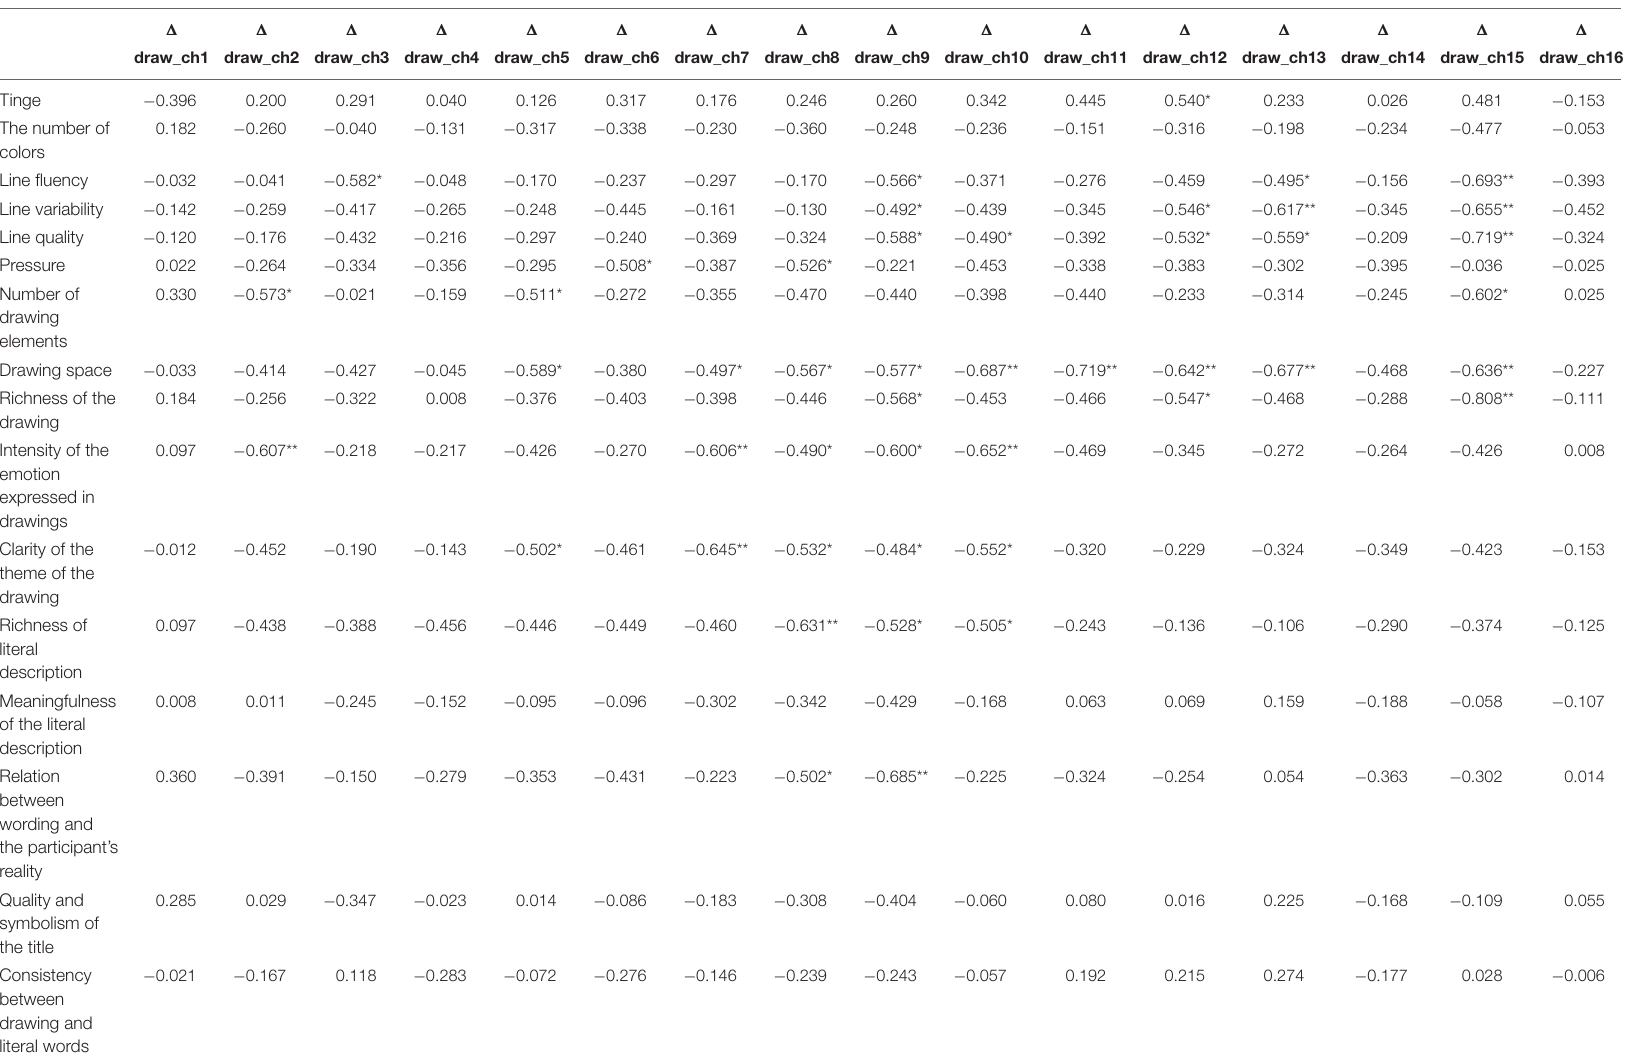
TABLE 8 | Correlation coefficients between drawing coding and brain data in the schizophrenia group during the emotional expression